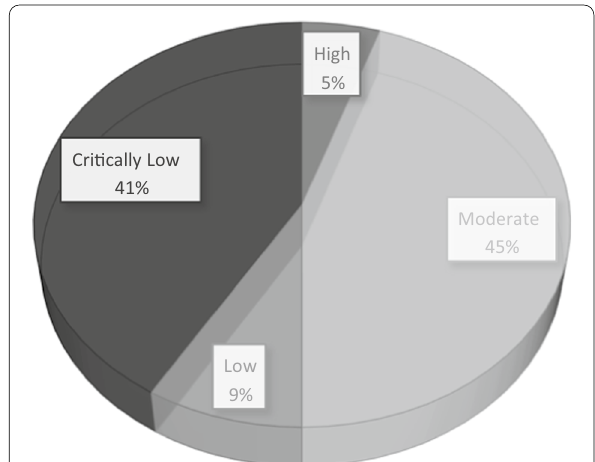
Fig. 2 The quality of included studies according to the